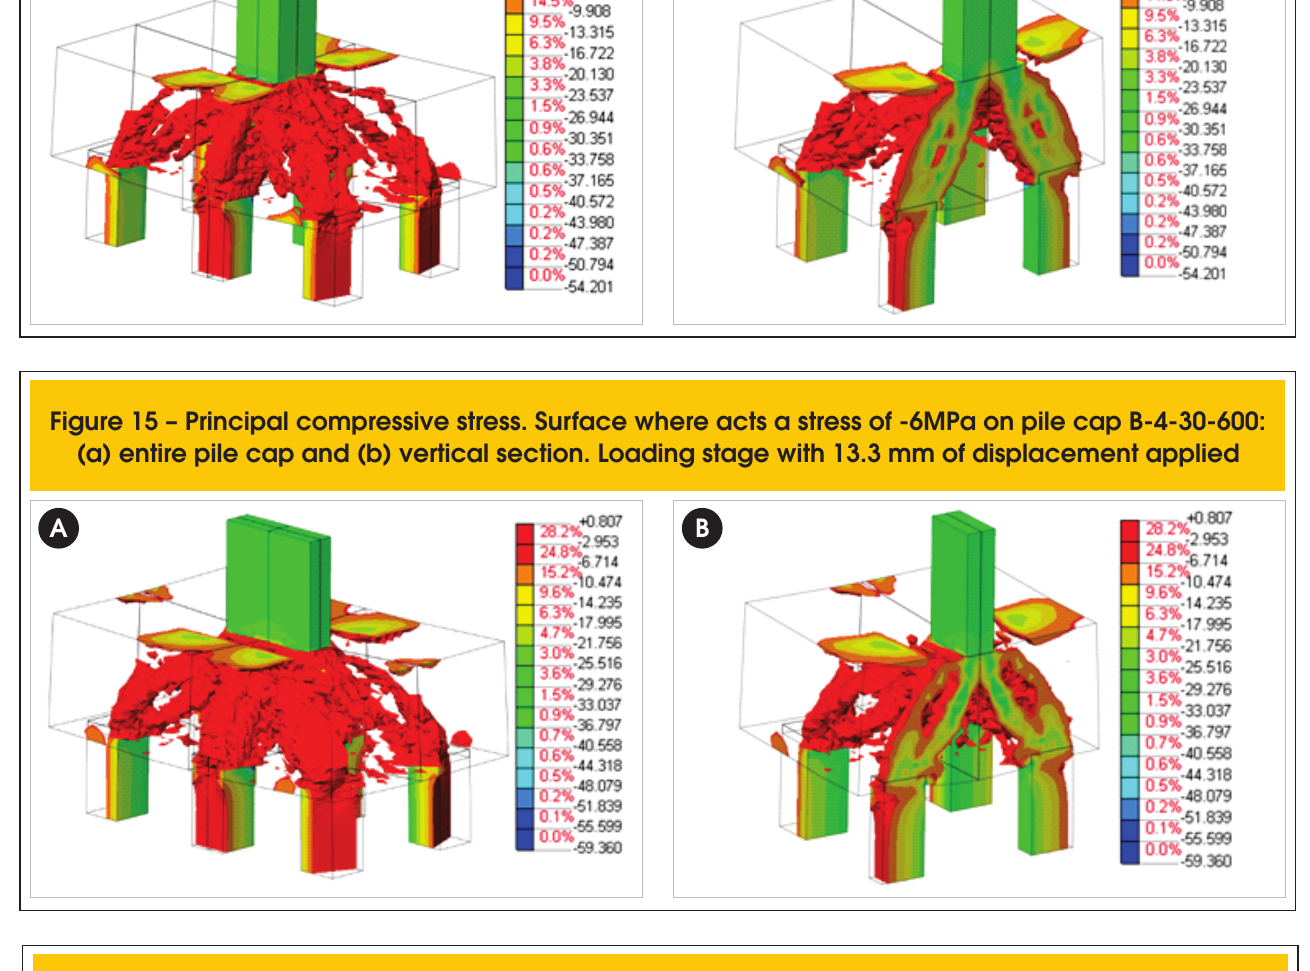
Figure 16 – Principal compressive stress. Surface where acts a stress of -6MPa on pile cap